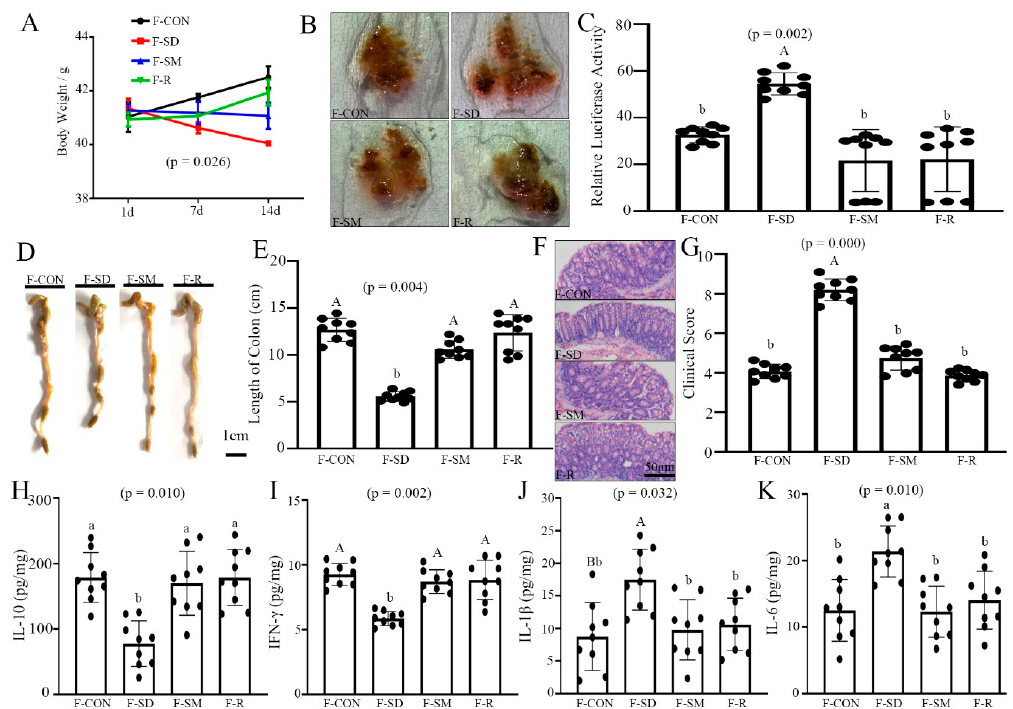
Figure 4. FMT re-established the intestinal microecology similar to CON, SD, and SD + MLT mice. ( A ) Body weight; ( B ) fecal occult blood; ( C ) relative luciferase activity for colonic permeability; ( D ), ( E ) colonic length; ( F ) H&E staining photographs (scale: 50 µ m); ( G ) histopathological score; ( H – K ): IL-10 ( H ), IFN- γ ( I ), IL-1 β ( J ), IL-6 ( K ) concentrations in the colon of the F-CON, F-SD, F-SM, and F-R groups. Values are presented as the mean ± SE. Differences were assessed using ANOVA and are denoted as follows: different lowercase letters or different uppercase letters: p < 0.05; different letters and one contains uppercase letters and the other is lowercase letters: p < 0.01; same letter: p >